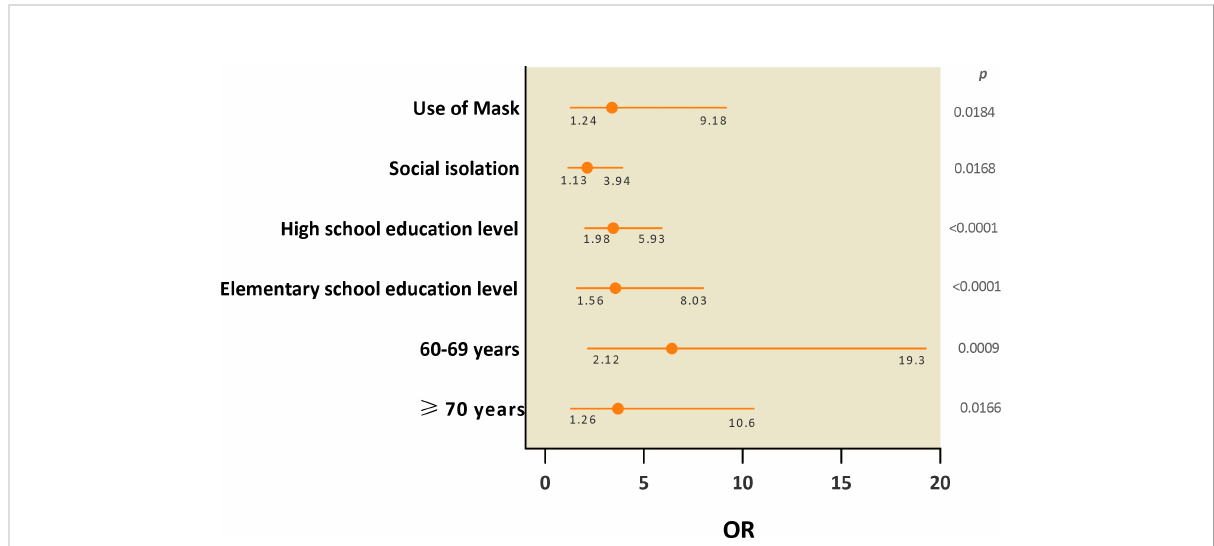
FIGURE 3 Socioeconomic and behavioral variables associated with the risk of SARS-CoV-2 infection after the fi rst two waves of COVID-19 in the city of Bele ́